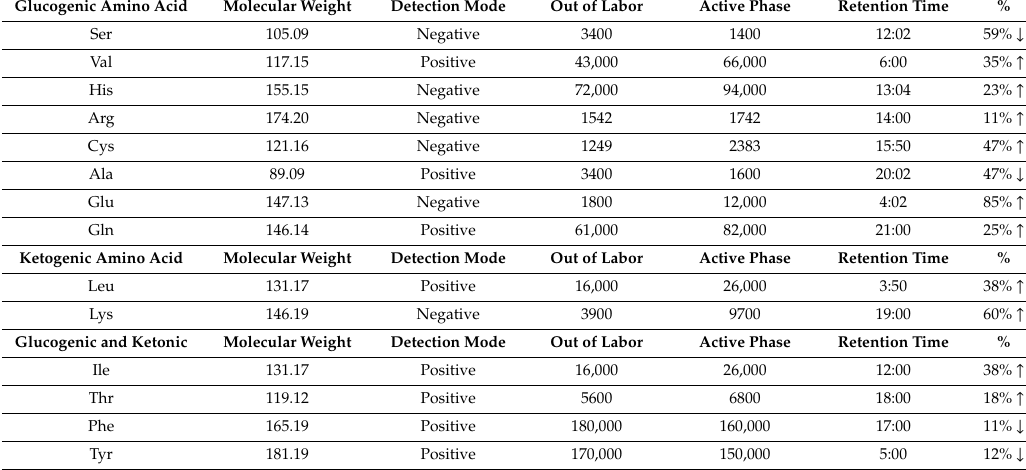
Table 2. Amino acid amounts extracted from the urine in the two stages of pregnancy (OL and IL-DP). The table refers to the relative concentration of the metabolites, calculated as a percentage of the total amino acids, by comparing the intensity of deconvolution of each amino